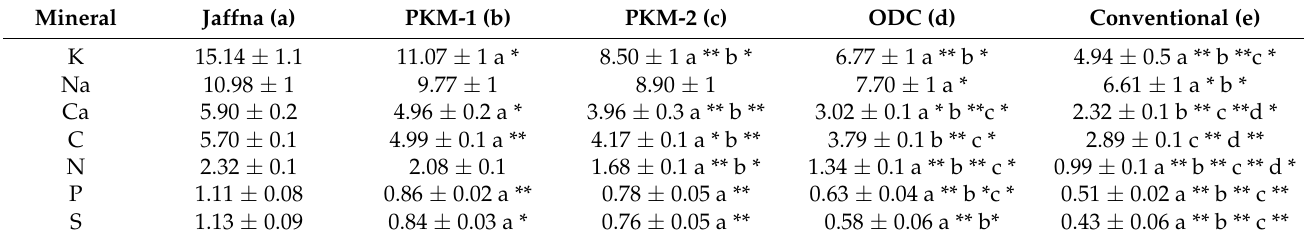
Table 1. Percent mineral content of five Moringa oleifera varieties.